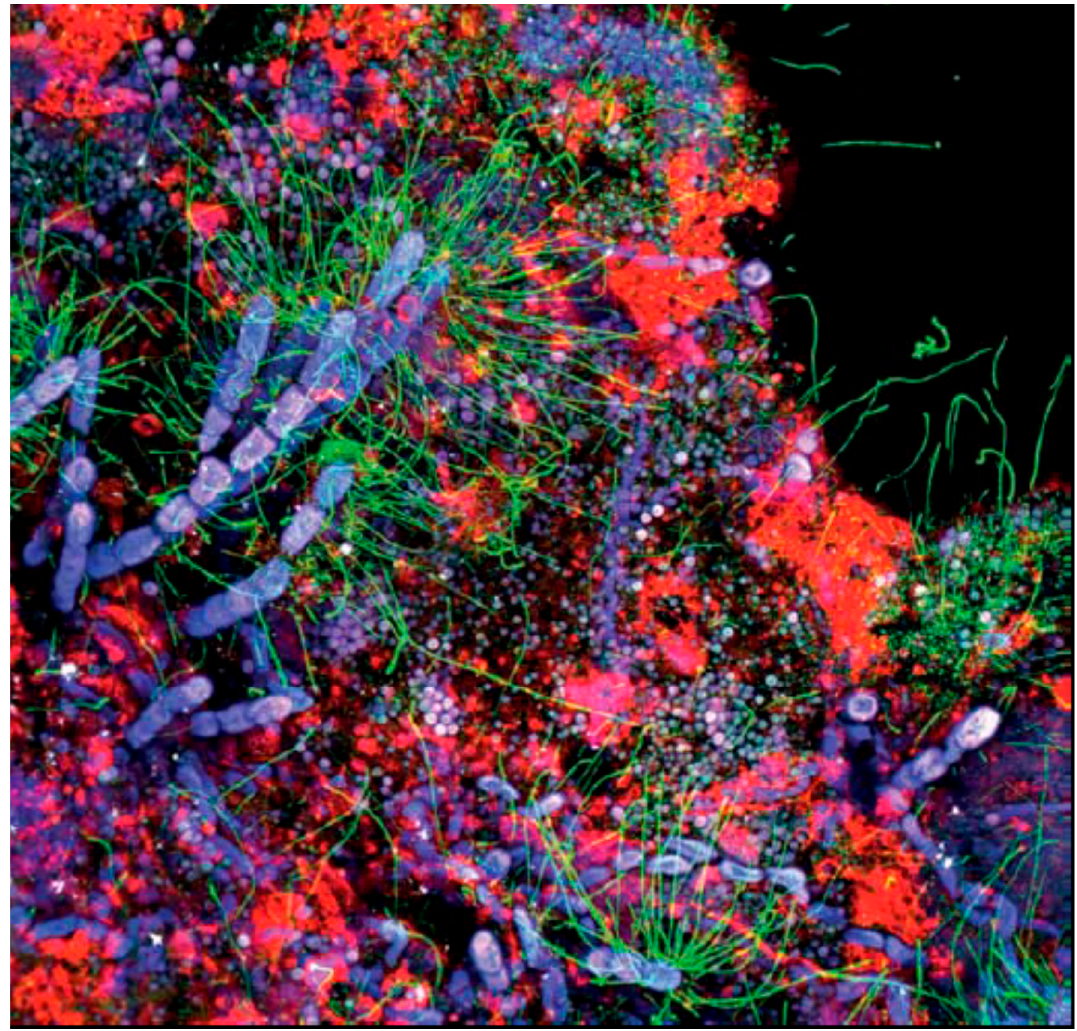
Figure 3. Fluorescent staining of a biofilm. Colour allocation: Nucleic acid stain (SybrGreen) = green; lectin stain (AAL-Alexa568) = red; autofluorescence of algae (chlorophyll A) = blue; autofluoresence of cyanobacteria = purple/white. Image dimensions: 246 × 246 µ m (from [34], with permission, source: [35]).